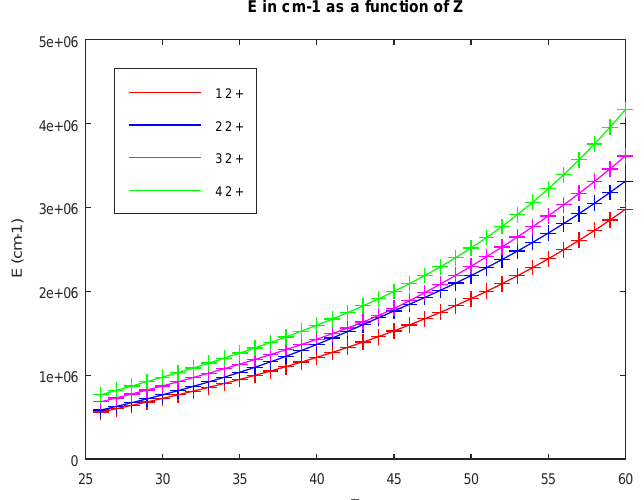
Figure 7. Plot of the energy of the four lowest even parity states with J = 2 as function of the nuclear charge Z . There is an energy level anti-crossing around Z = 44. The M-file was edited, and we added the legend, see Section